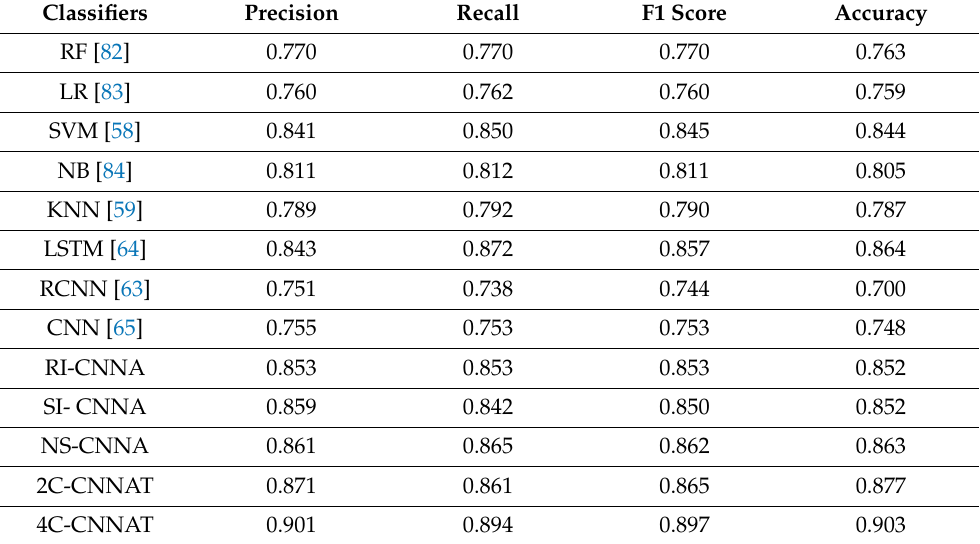
Table 4. 4C-CNNAT performance comparison with various ML/DL classifiers using RUSAD